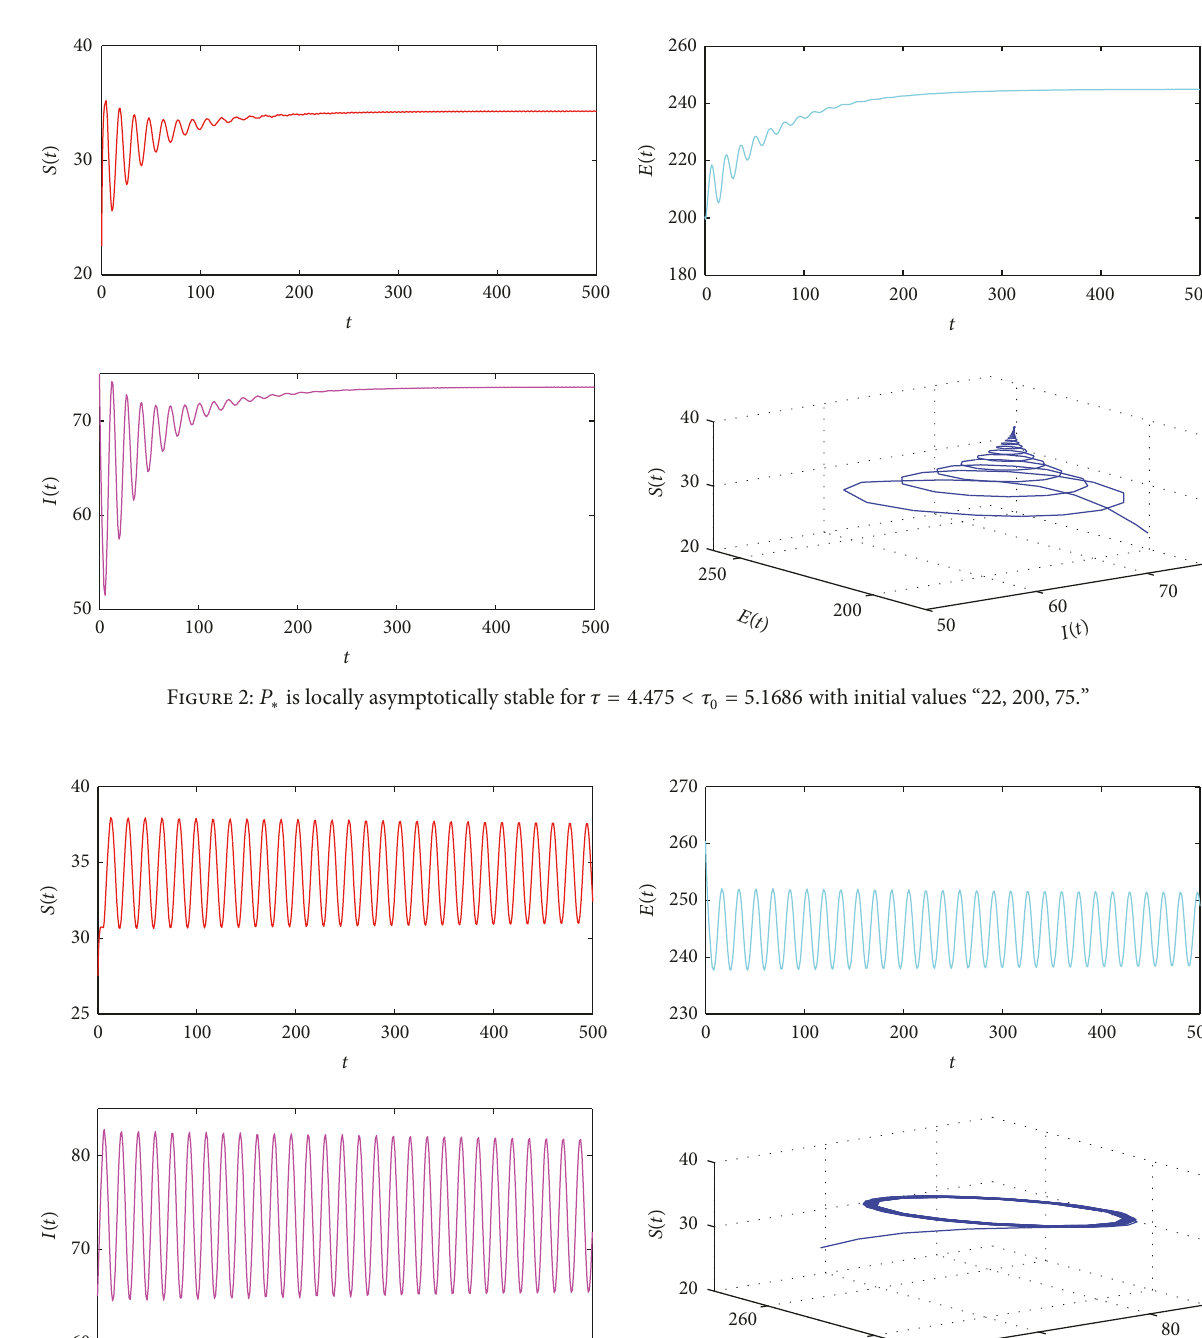
center manifold theorem due to Hassard et al. [21], direction and stability of the Hopf bifurcation are determined. Finally, through numerical simulations, it can be concluded that the period used to cure the infectious population plays an important role in the disease spreading and the disease may be controlled by shortening the period used to cure the infectious